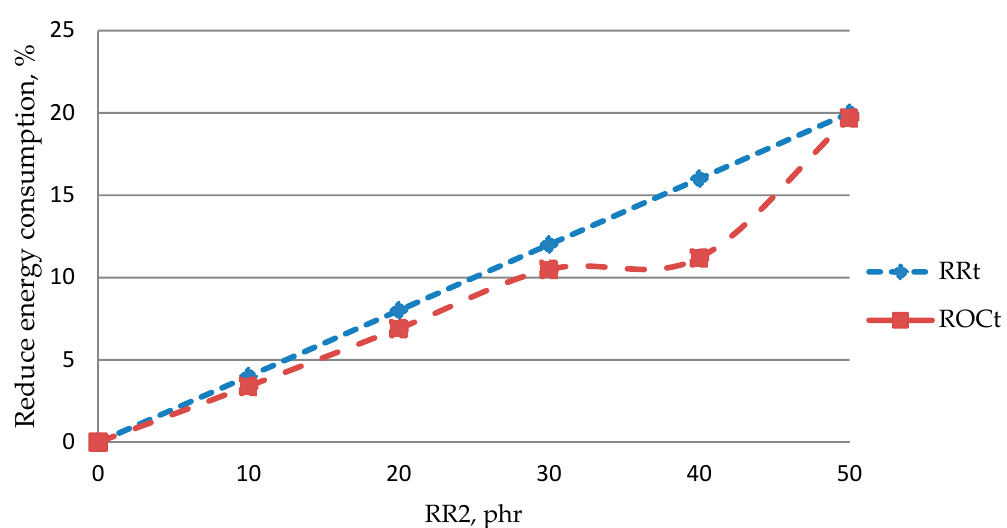
Figure 8. Reducing energy consumption in the case of the use of regenerated rubber RR2.